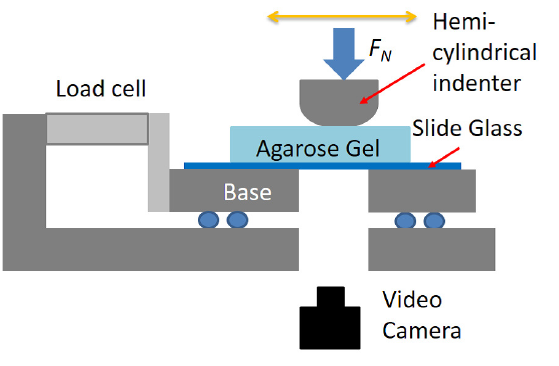
Figure 8. Schematic of reciprocating friction